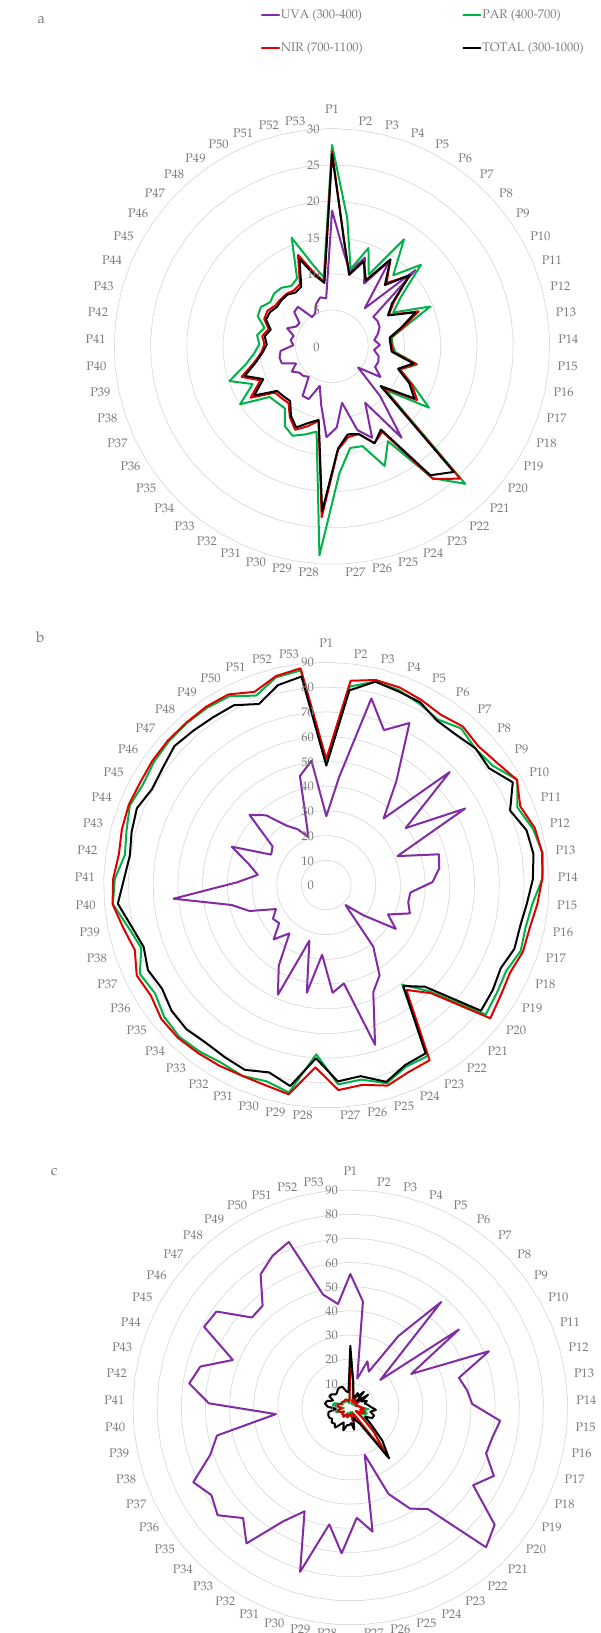
Figure 5. Radiation ( a ) reflected, ( b ) transmitted and ( c ) absorbed in the different spectral regions of the polymeric films.